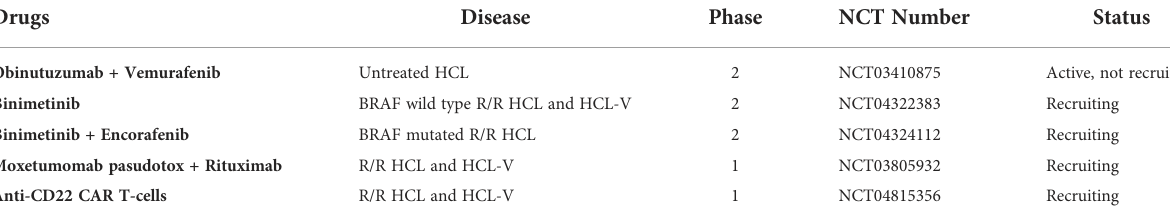
TABLE 3 Current clinical trials in HCL and HCL-like disorders.